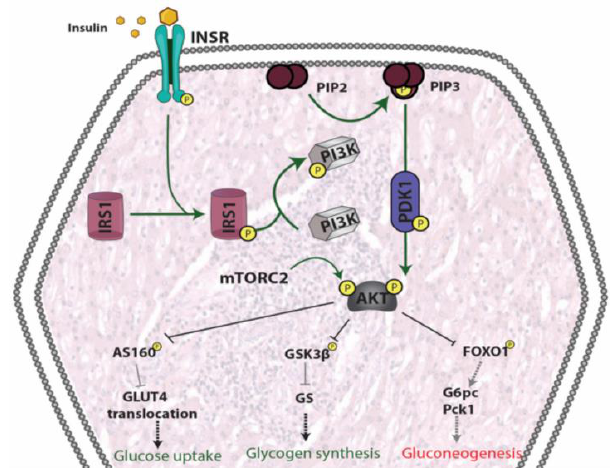
Figure 5. Signaling pathways involved in insulin signaling in hepatocytes. Binding of insulin to INSR induces IRSs recruitment and phosphorylation. Phosphorylated IRSs activate PI3K, generating